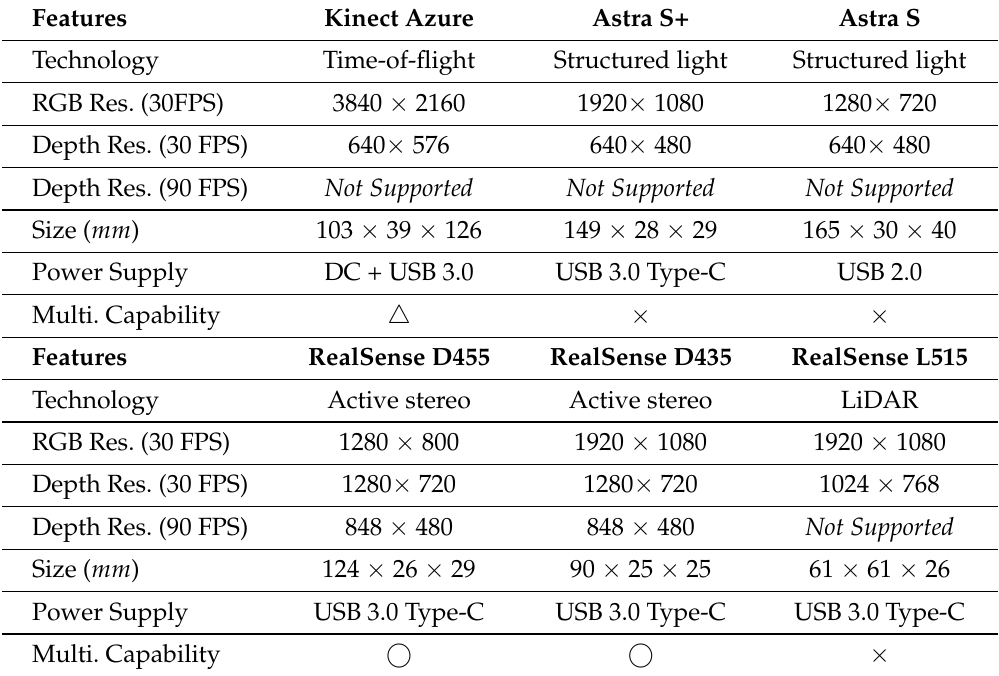
Table 1. Specifications of commercial RGB-D